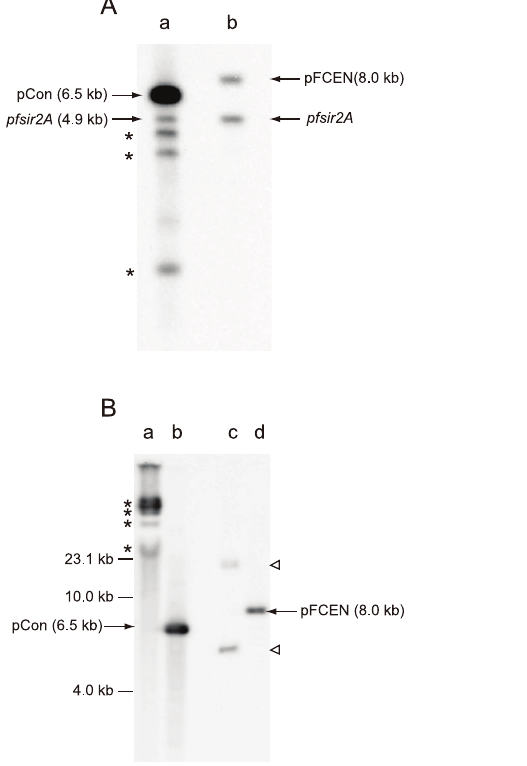
Figure 5. Southern Analysis of pFCEN in the Parasites. (A) To determine the copy number of pCon (lane a) and pFCEN (lane b), Southern analyses were performed by using two probe DNAs, the gfp and pfsir2A genes. The gfp and pfsir2A probes recognised the plasmids and the single, endogenous genomic pfsir2A copy, respectively. In this analysis, the signal from the pfsir2A gene was used as the internal control. The copy number of each plasmid was determined by comparing the signal intensities of the plasmids with that of the internal control. The asterisks mark three unexpected signals found in the genomic DNA including pCon. In contrast, corresponding signals were not detected in the genomic DNA including pFCEN. Therefore, these signals likely result from various derivatives, which might be irregularly generated from pCon during the replication, suggesting that pfcen5-1.5 ensured the accurate replication of the plasmid. (B) The parasites transfected with the pFCEN and the pCon plasmids were maintained in the presence of the drug for 2 months, and their genomic DNA, including the plasmids, were purified. Southern analysis of both plasmids in the parasites was performed using purified genomic DNA and the gfp gene as a probe DNA. In this analysis, the undigested genomic DNA (lane a, pCon, and lane c, pFCEN) and the Bam HI- digested DNA (lane b, pCon, and lane d, pFCEN) were used. The arrows indicate the Bam HI-digested pFCEN and pCon. The upper and lower triangles indicate the closed circular and the super-coiled forms of pFCEN, respectively. Asterisks indicate concatemers of pCon that were detected in the undigested genomic DNA containing pCon. doi:10.1371/journal.pone.0033326.g005 homologous recombination between pFCENv2 and the genome of the parasites (data not shown). Therefore, these results clearly showed that the pFCENv2 can be maintained as an episomal plasmid as well as the pFCEN. Because similar suppression of homologous recombination was observed with the centromere plasmid of P. berghei in which the recombination is more readily occurred than in P. falciparum , the recombination between the centromere plasmid and the genomic DNA of P. falciparum might be suppressed by the function of pfcen5-1.5 .